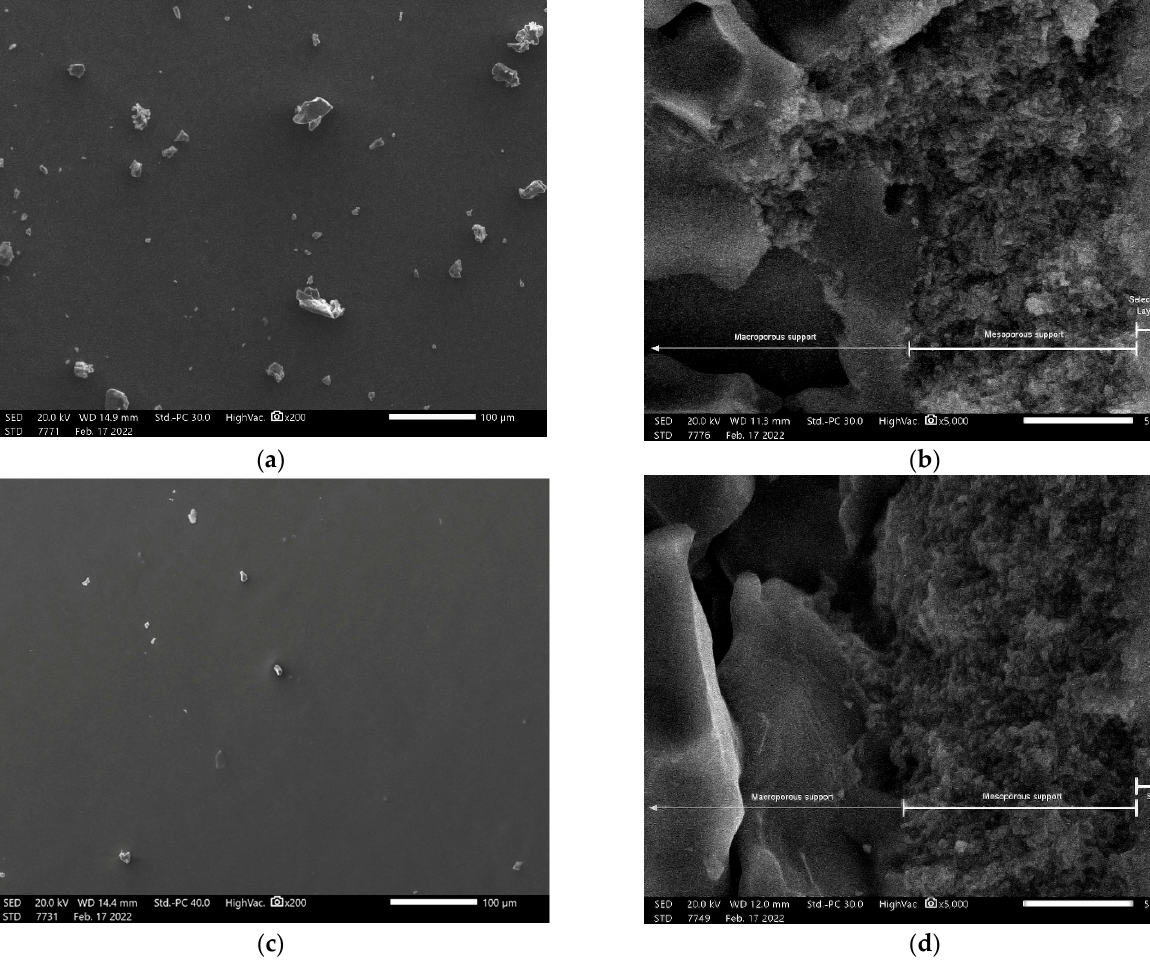
Figure 8. Top-surface ( a , c ) and cross-sectional ( b , d ) scanning electron microscopy (SEM) images of the modified membrane M-A180 ( a , b ) and M-B180 ( c , d ).